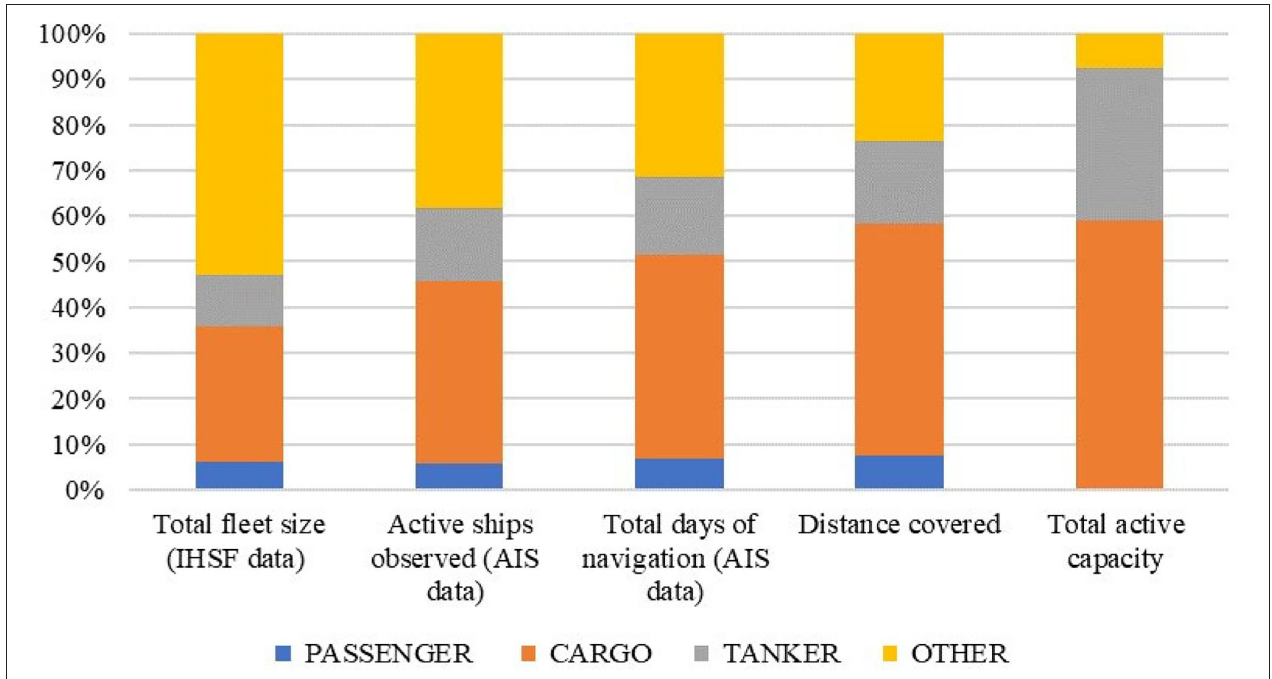
FIGURE 1 | Main characteristics of existing passenger, cargo and thanker ships (Data source: IMO–International Maritime Organization,